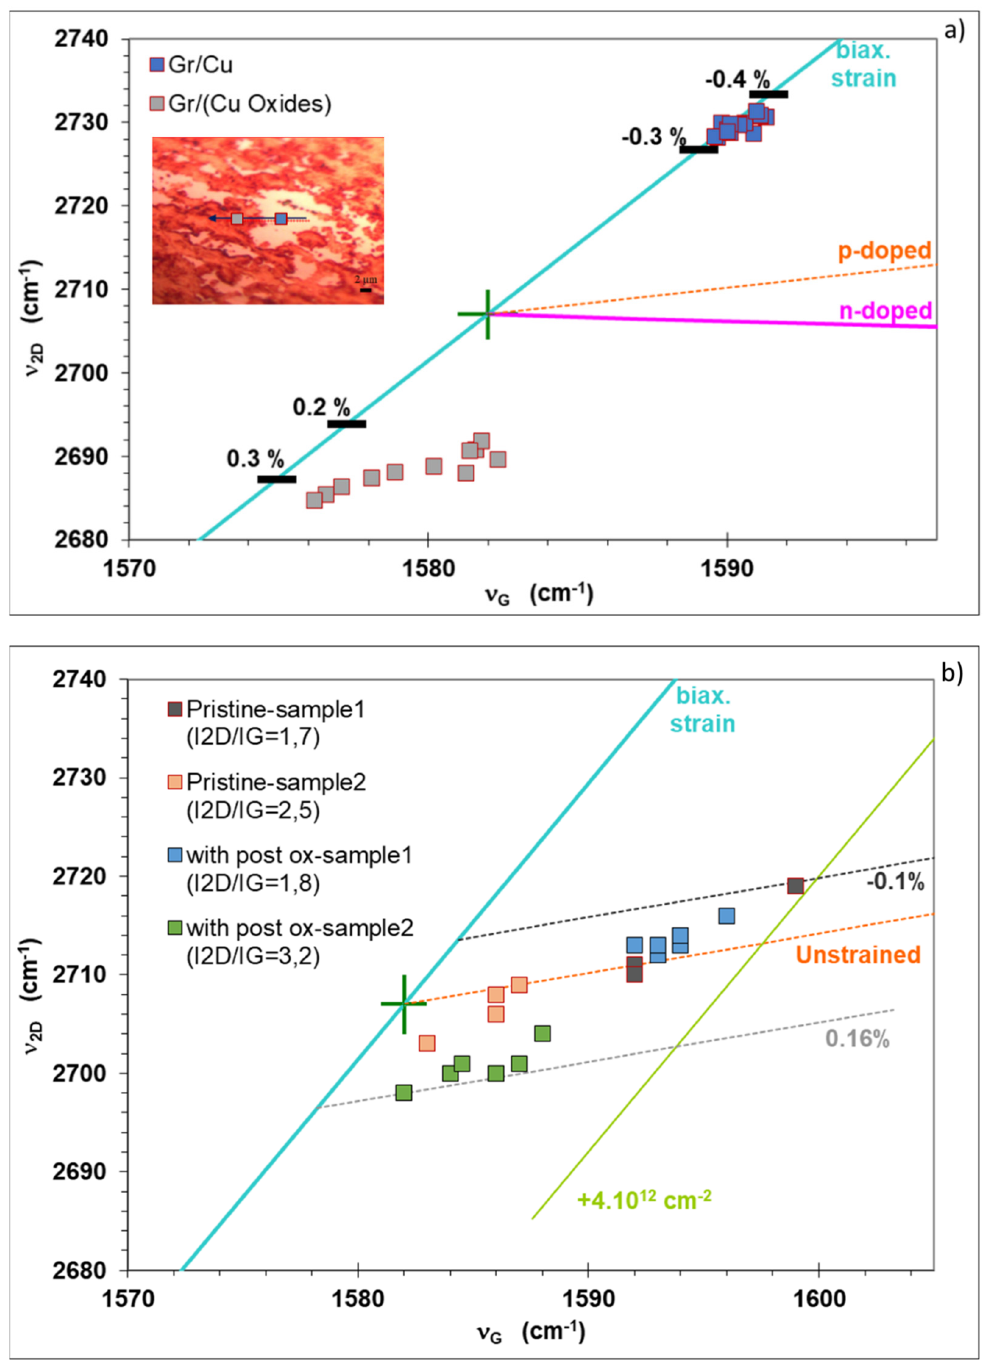
Figure 6. Correlation between the frequencies of the G and 2D Raman peaks of graphene ( ν G , ν 2D ), from Raman spectra of 4 samples, with and without post-growth annealing. The green cross repre- sents ( ν G0 , ν 2D0 ) for undoped and unstrained graphene. The blue line (biax. strain) represents an estimation of ( ν G , ν 2D ) for undoped graphene under biaxial strain, while the orange (respectively pink) dashed line corresponds to unstrained p-doped (n-doped) graphene. Horizontal black lines in panel a refer to the values of biaxial strain. ( a ) before transfer, ( b ) after transfer, the green line parallel to the blue one represents the ( ν G , ν 2D ) strain dependency for a p-type doping of 4 × 10 12 cm − 2 .